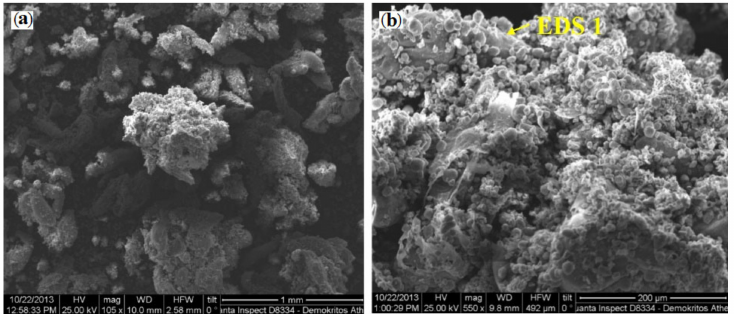
Figure 10. SEM images of the 34.4% NiO—45.6% Al—20% Al 2 O 3 catalyst after 900 ◦ C treatment: ( a ) sample at 1 µ m scale; ( b ) sample at 200 µ m scale.